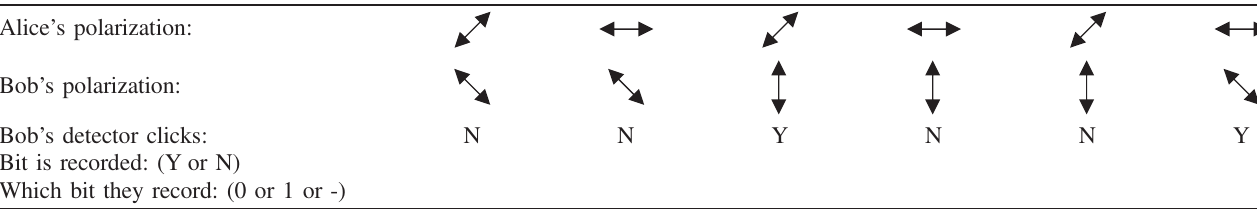
TABLE I. In the QKD protocol in the QuILT, students are asked to complete the empty boxes in the table predicting what should happen in a given situation based upon their understanding of the QKD protocol involving nonorthogonal polarization states of a